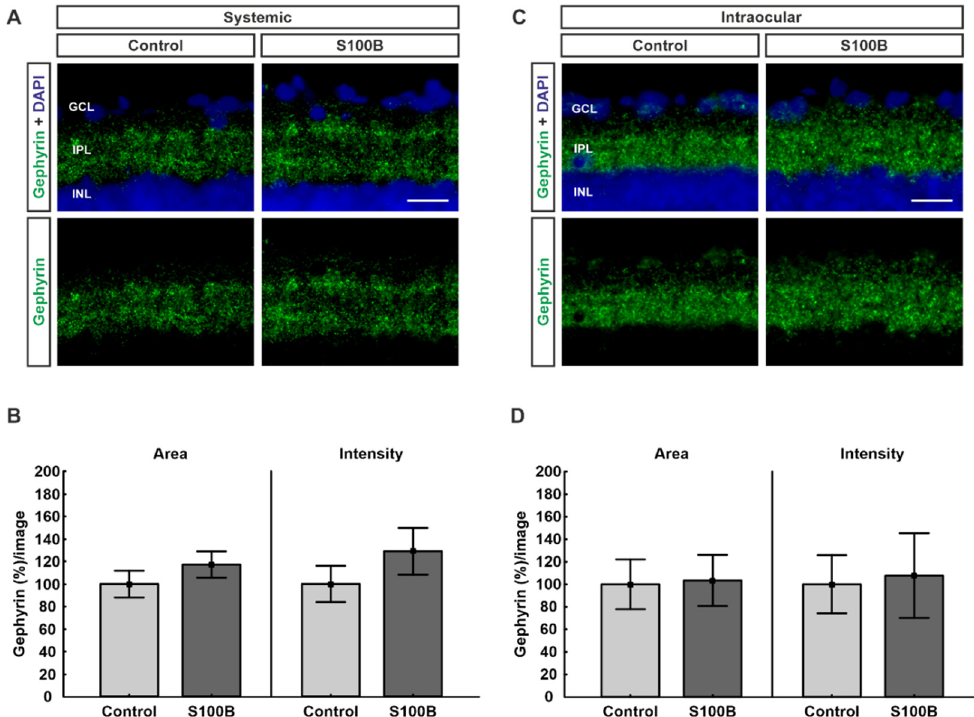
Figure 1. Gephyrin remains unchanged. ( A ) Retinas from systemically immunized animals ( n = 7 / group) were stained against gephyrin (green). Cell nuclei were visualized with 4 (cid:48) ,6 diamidino-2-phenylindole (DAPI; blue). ( B ) In comparison to controls, no alterations could be observed in the gephyrin stained area ( p = 0.31) and intensity ( p = 0.29) in the S100B group. ( C ) Retinas from animals with intraocular S100B injection ( n = 7 / group) were stained against gephyrin (green). Cell nuclei were visualized with DAPI (blue). ( D ) No di ff erences were noted regarding the percentage of stained area ( p = 0.91) as well as the percentage of intensity ( p = 0.86) between both groups. Abbreviations: GCL: ganglion cell layer; IPL: inner plexiform layer; INL: inner nuclear layer. Values are mean ± SEM. Scale bars: 20 µm.